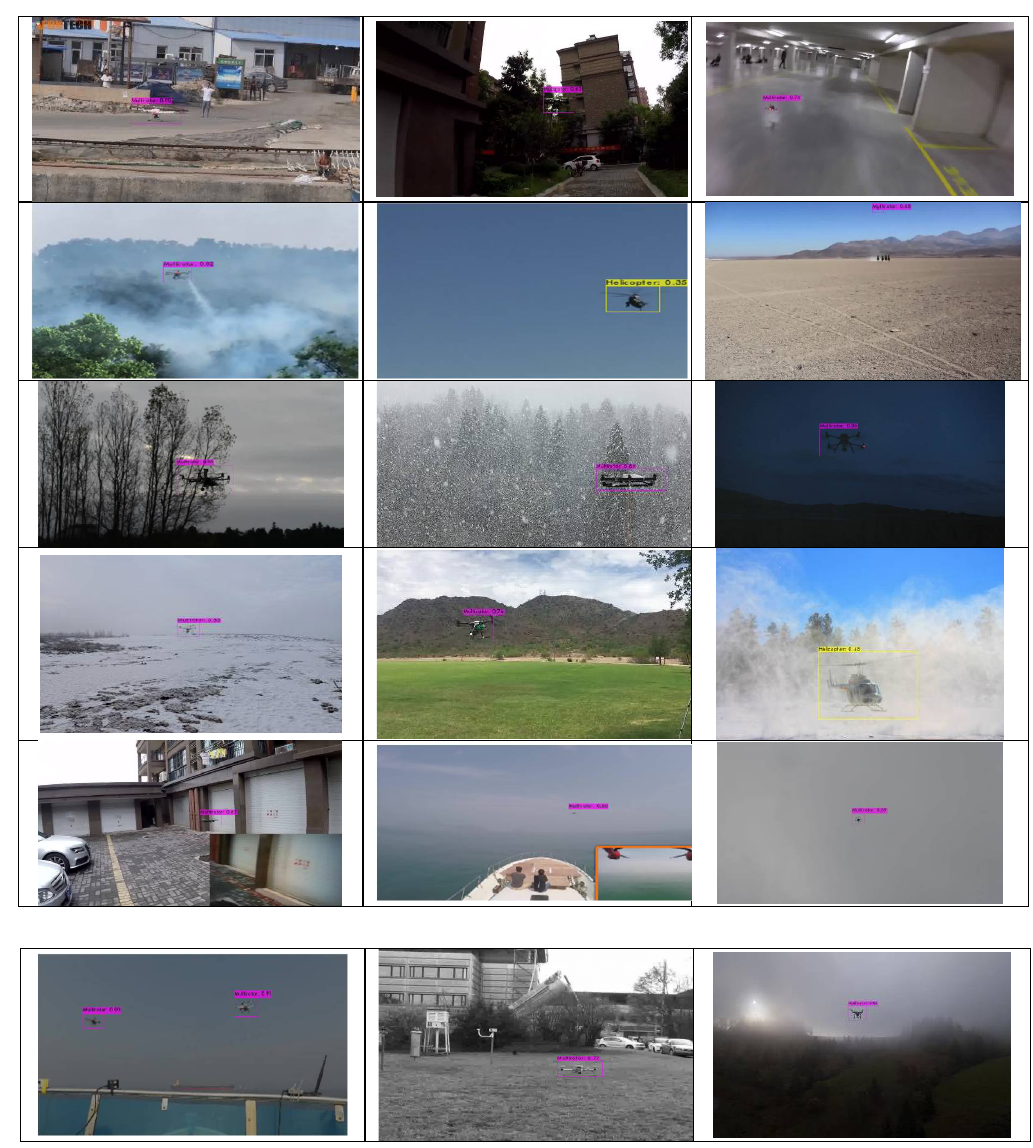
Figure 18. Some samples of small drone detection in crowded background, different weather, and lighting conditions.